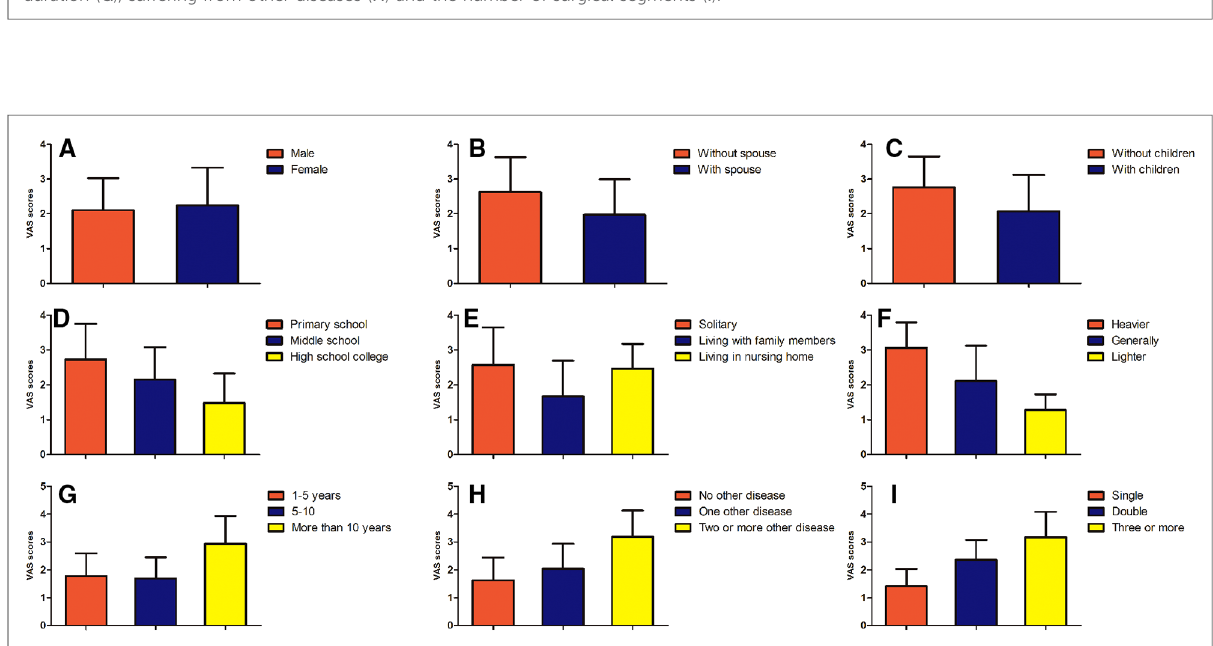
FIGURE 2 Comparison of VAS scores after lumbar fusion in different demographic characteristics. Comparison of VAS scores after lumbar fusion in different situations, such as gender ( A ), marital status ( B ), with or without children ( C ), education level ( D ), living status ( E ), economic pressure ( F ), disease duration ( G ), suffering from other diseases ( H ) and the number of surgical segments ( I ).